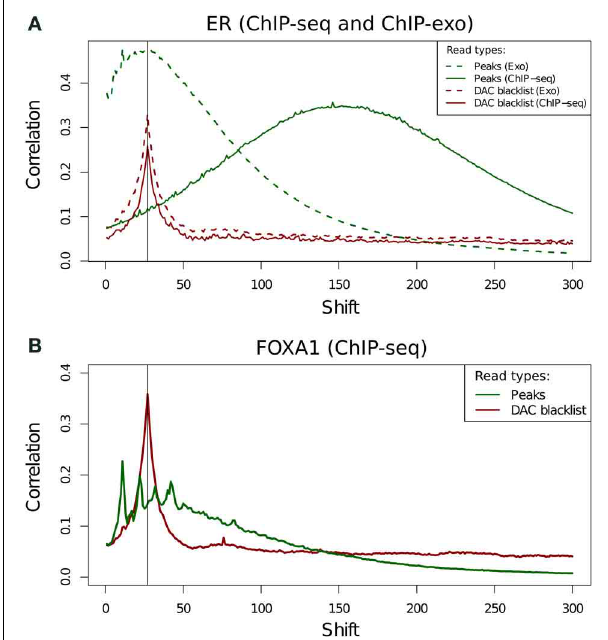
FIGURE 9 | (A,B) Cross-correlation profiles for reads in peaks and reads in DAC consensus blacklist for ChIP-seq and ChIP-exo ER ChIP (A) and for ChIP-exo FoxA1 ChIP (B) .